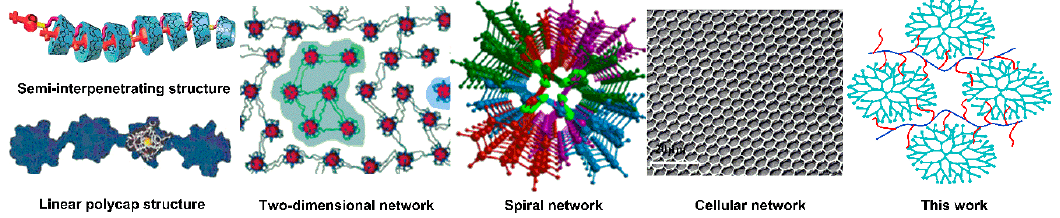
Figure 1. The typical supramolecular systems with different structures.